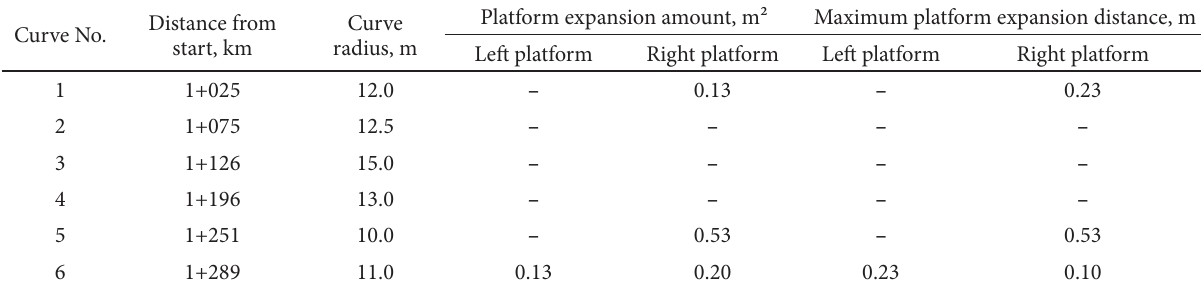
Table 4. Amounts of expansion required in curves for midibus as a result of driving analysis Curve No.